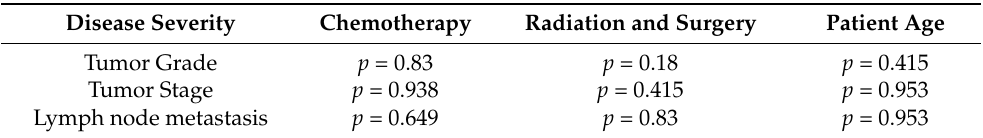
Figure 4. Kaplan–Meier curves of ONB patient cancer-specific survival within age at diagnoses and associated chemotherapy treatment status. Ages at diagnoses were stratified at ( a ) 0–20 years, ( b ) 21–40 years, ( c ) 41–60 years, ( d ) and greater than 60 years. Abbreviations: chemo, chemotherapy. Table 1. Generalized linear model statistics demonstrating CSS interactions between ONB disease severity (tumor stage, grade, and lymph node involvement) and chemotherapy, radiation and surgery or patient age at